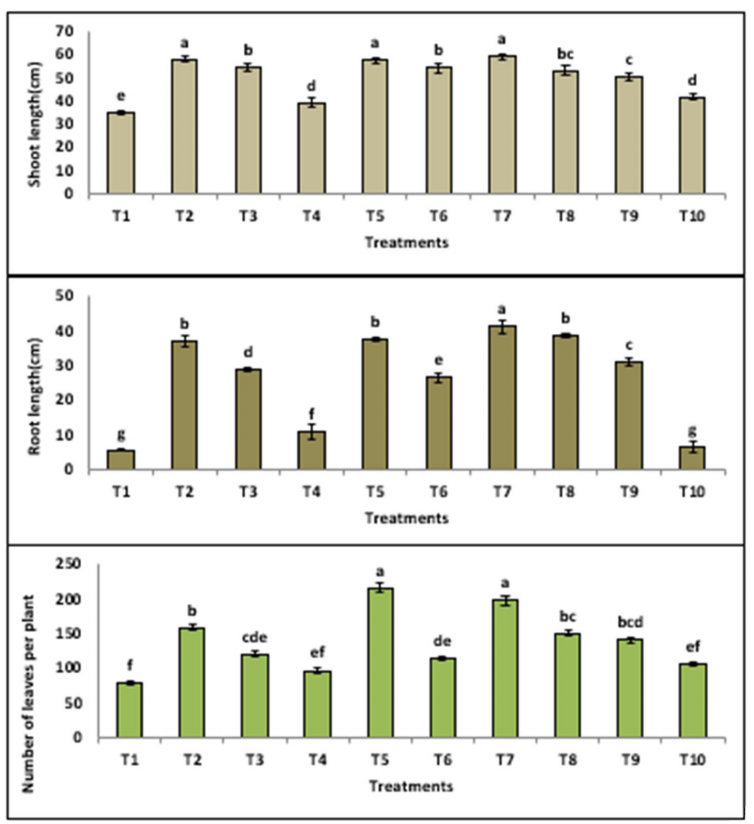
Figure 4. Morphological indicators of tomato plant (shoot length, root length and number of leaves) treated with PGPF. (T1) infected control, (T2) healthy control, (T3) healthy + M. circinelloides , (T4) infected + M. circinelloides , (T5) healthy + P. oxalicum , (T6) infected + P. oxalicum , (T7) healthy + A. niger , (T8) infected + A. niger , (T9) healthy + A. flavus , (T10) infected + A. flavus